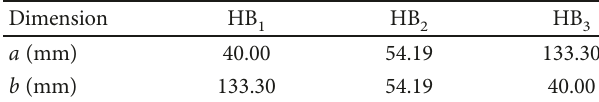
Table 1: Dimensions of the equivalent resonant